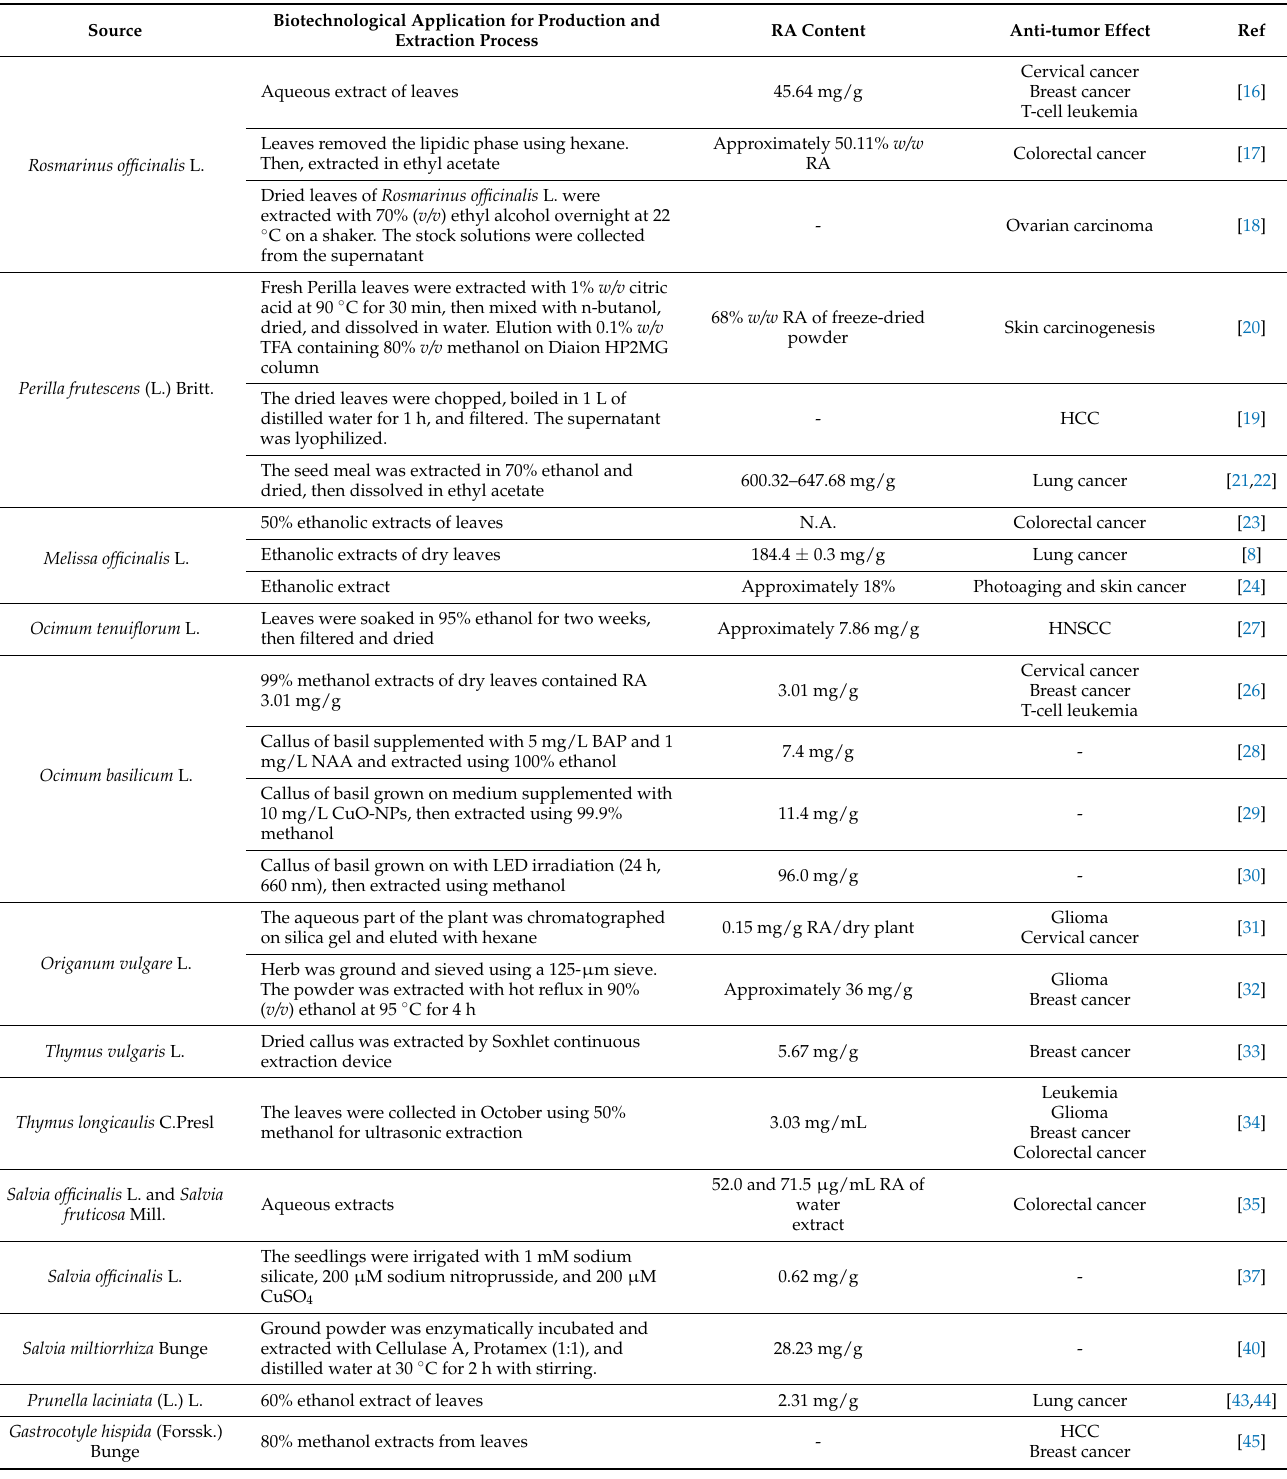
Table 1. The production process and anti-tumor effects of plants constitute a great source of